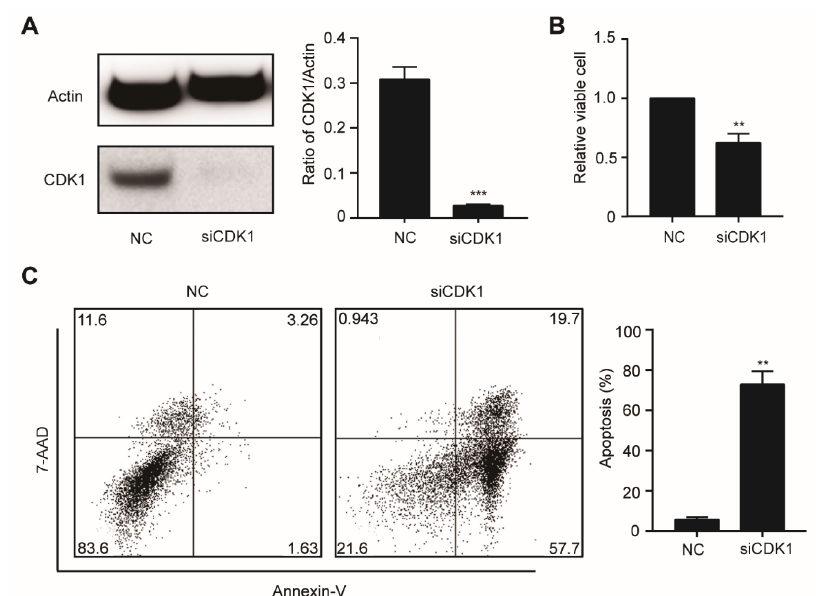
Figure 4. The knockdown of CDK1 inhibits proliferation and induces apoptosis in OCI-AML3 cells. ( A ) The OCI-AML3 cells were transfected with scrambled siRNA (negative control, NC) and siCDK1, respectively, and examined by Western blotting using the indicated antibodies. ( B ) Cell proliferation was analyzed by the CCK-8 assay. ( C ) Apoptosis rate was assessed by Annexin V/7-AAD staining and flow cytometry. Data are presented as mean ± SD, ** p < 0.01, *** p < 0.001.